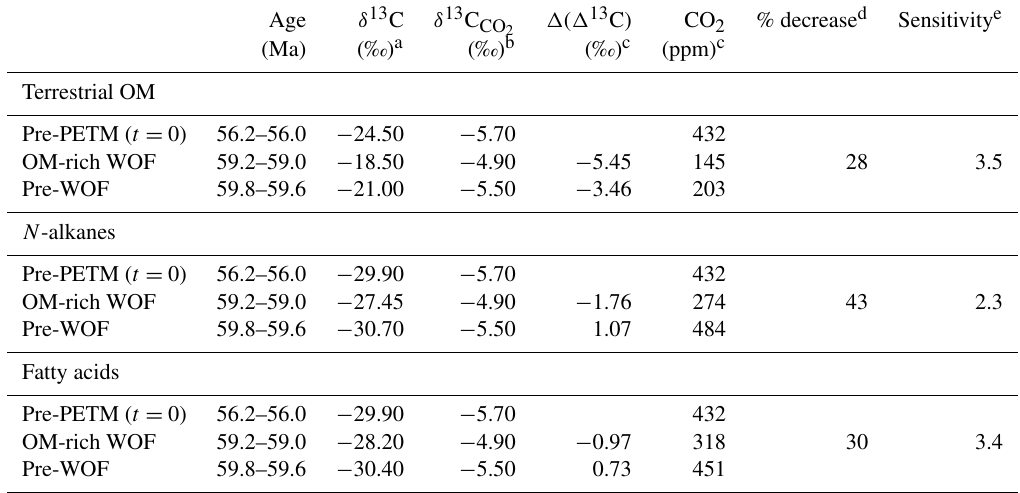
Table 1. Parameters used to derive atmospheric CO 2 estimates for Waipawa and underlying